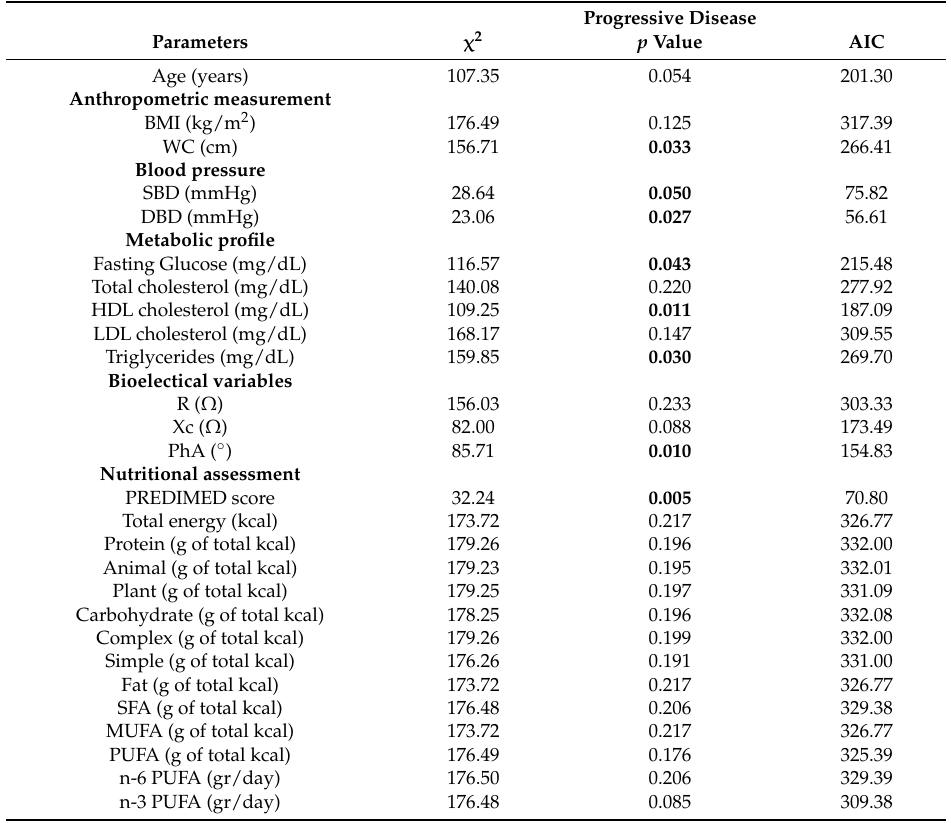
Table 6. Multinomial logistic regression model to assess the association between disease status with age, anthropometric measurement, blood pressure, metabolic profile, bioelectrical variables and nutritional